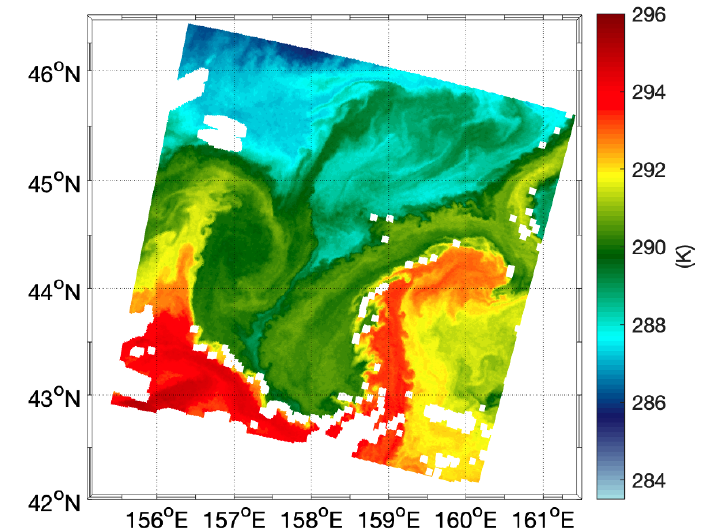
Figure 2. Sea surface temperature scene acquired by the S3 SLSTR sensor in the North Pacific acquired on 15 September 2020, 09:00 UTC. White areas stand for SST with quality level lower than 5.